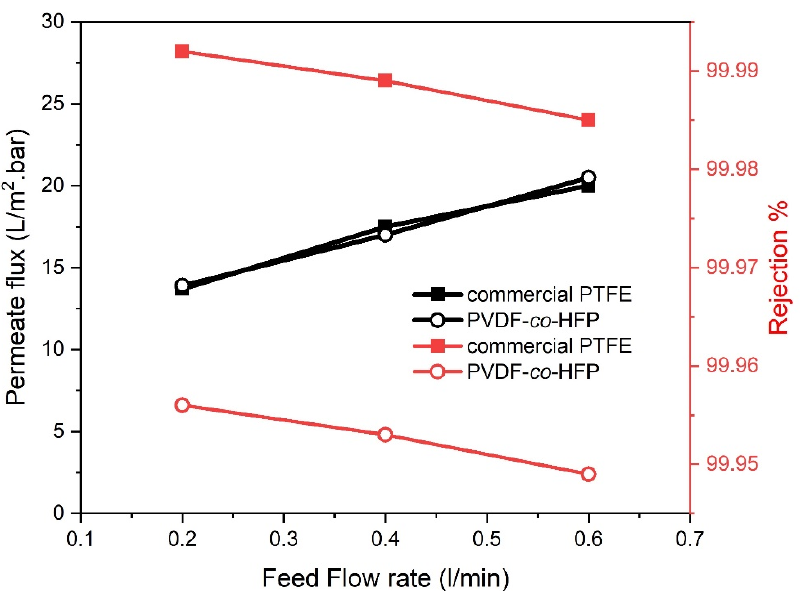
Figure 4. E ff ect of feed flowrate on permeate flux and salt rejection for 35 g / L NaCl feed solution, 65 ◦ C feed temperature and 300 L / h sweeping gas flow rate for PTFE and PVDF-co-HFP Figure 4. Effect of feed flowrate on permeate flux and salt rejection for 35 g/L NaCl feed solution, 65 °C feed temperature and 300 L/h sweeping gas flow rate for PTFE and PVDF-co-HFP membranes.